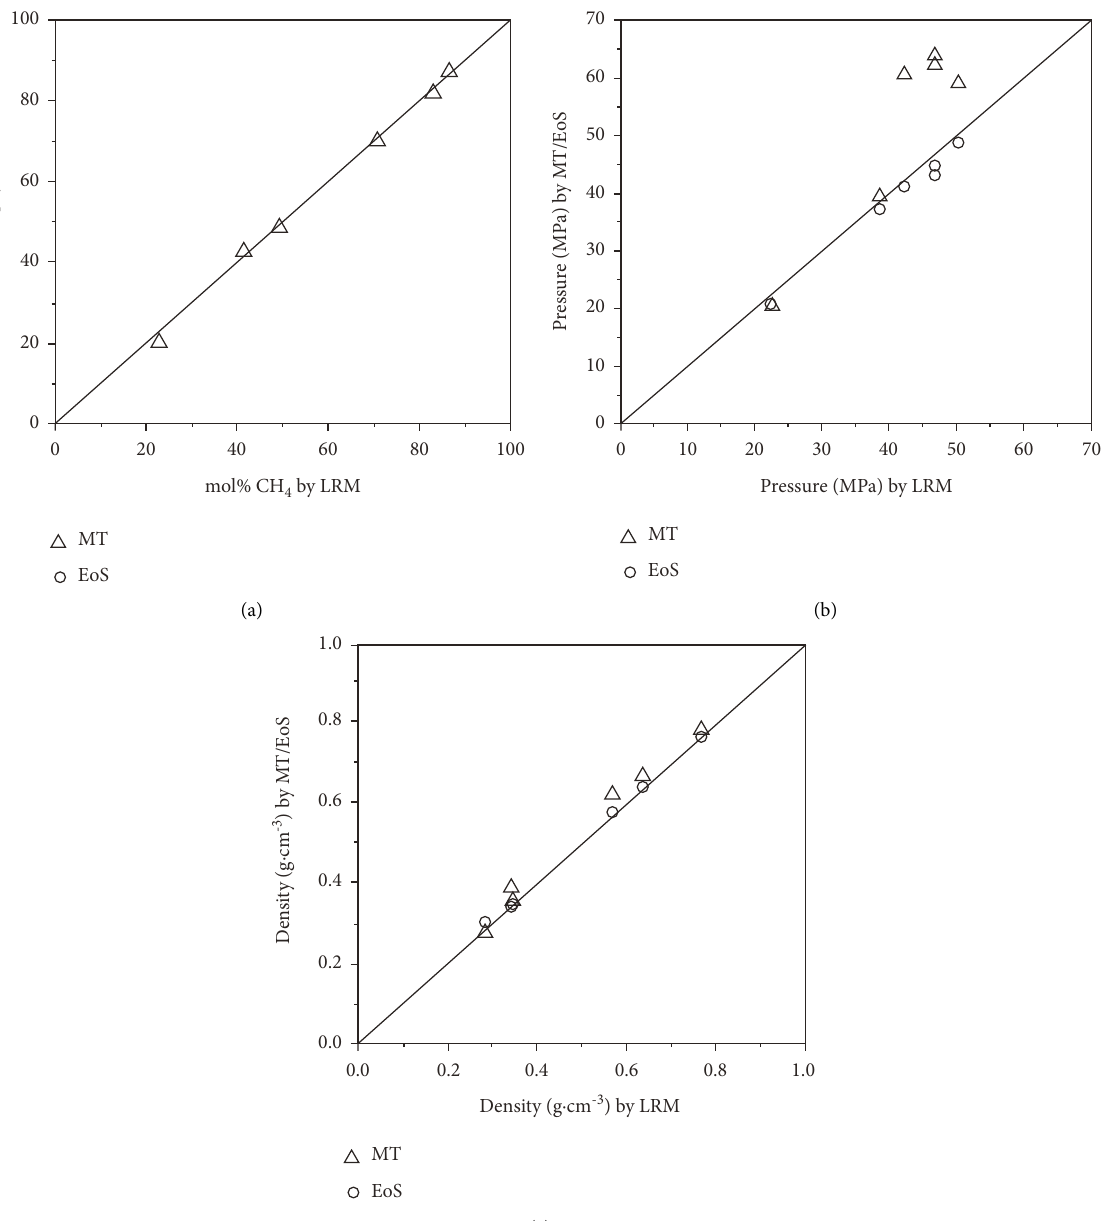
Figure 14: Comparison of (a) mol% CH 4 , (b) pressure, and (c) density of CO 2 -CH 4 mixtures in FSCCs based on laser Raman (LRM) and microthermometry (MT) data. Note that the pressure (b) and density (c) calculated by GERG-2008 EoS are based on X Raman and ρ Raman , and X Raman and P Raman ,